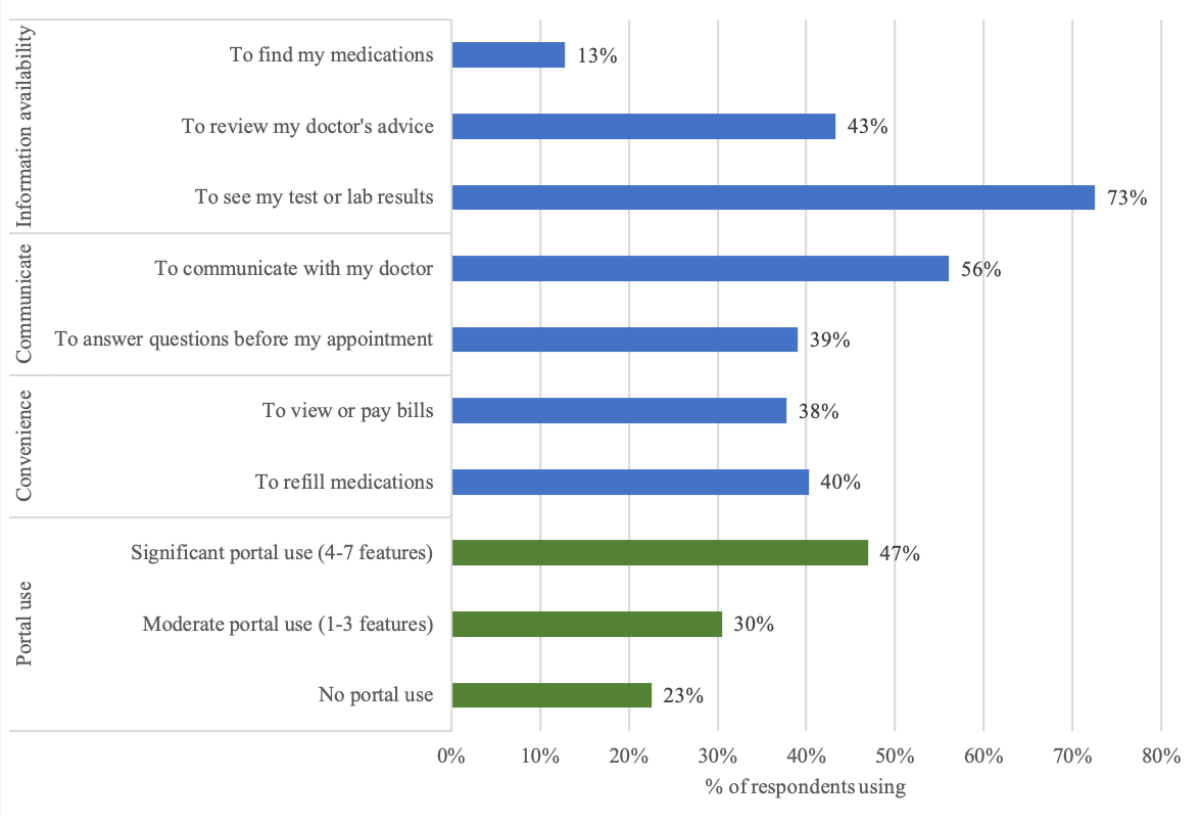
Figure 2. Use of available portal functions among respondents.